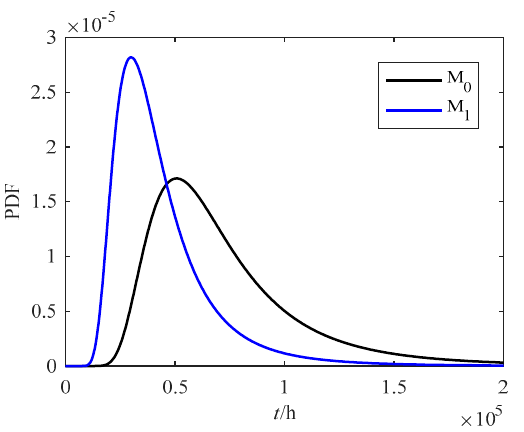
Figure 6. PDF of storage life under 25 °C for O-type rubber seal rings based on of M 0 and M 1 .